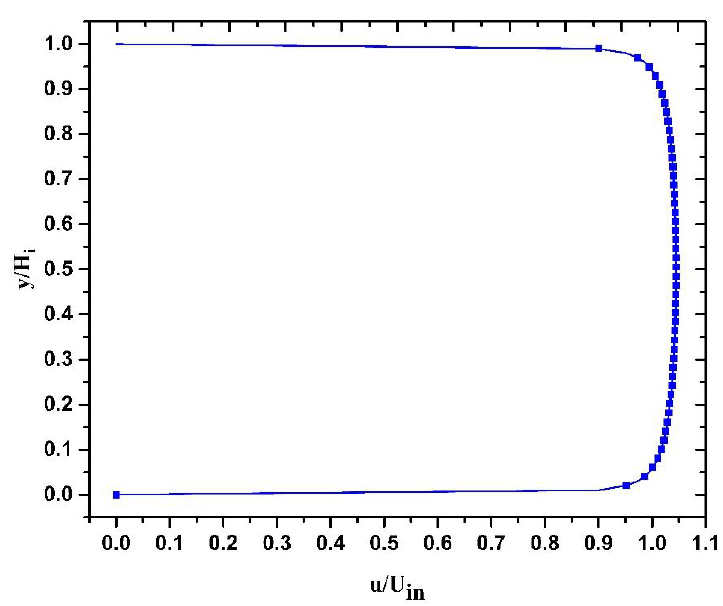
Figure 3. Fully developed inflow velocity profile at the vertical symmetry plane.